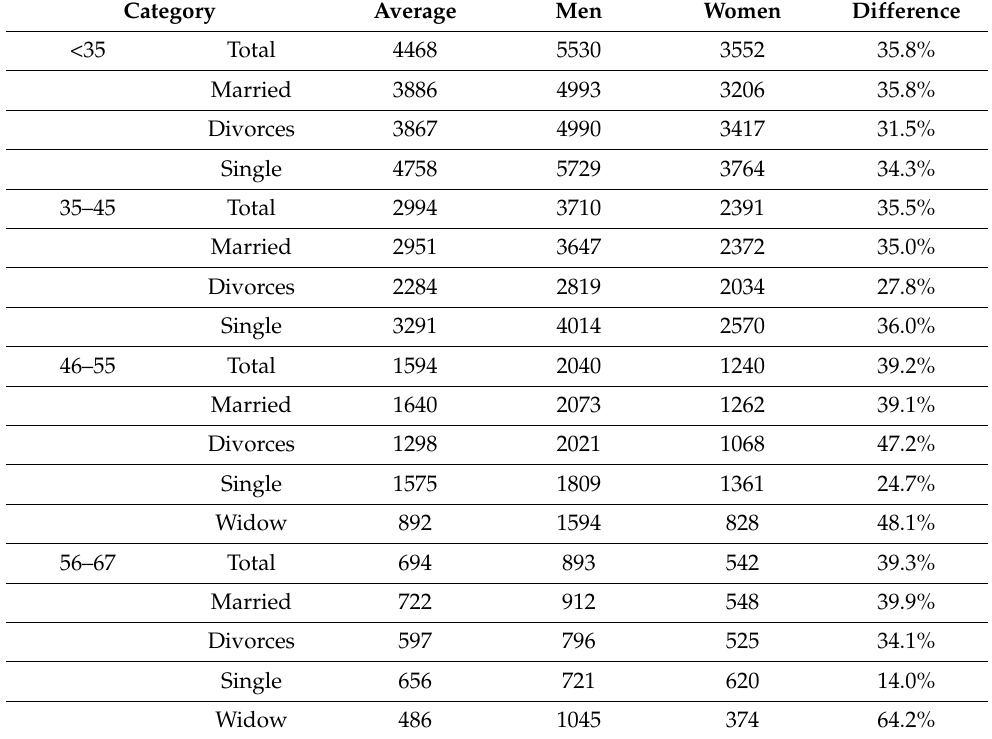
Table 2. Expected Monthly Funded Benefits